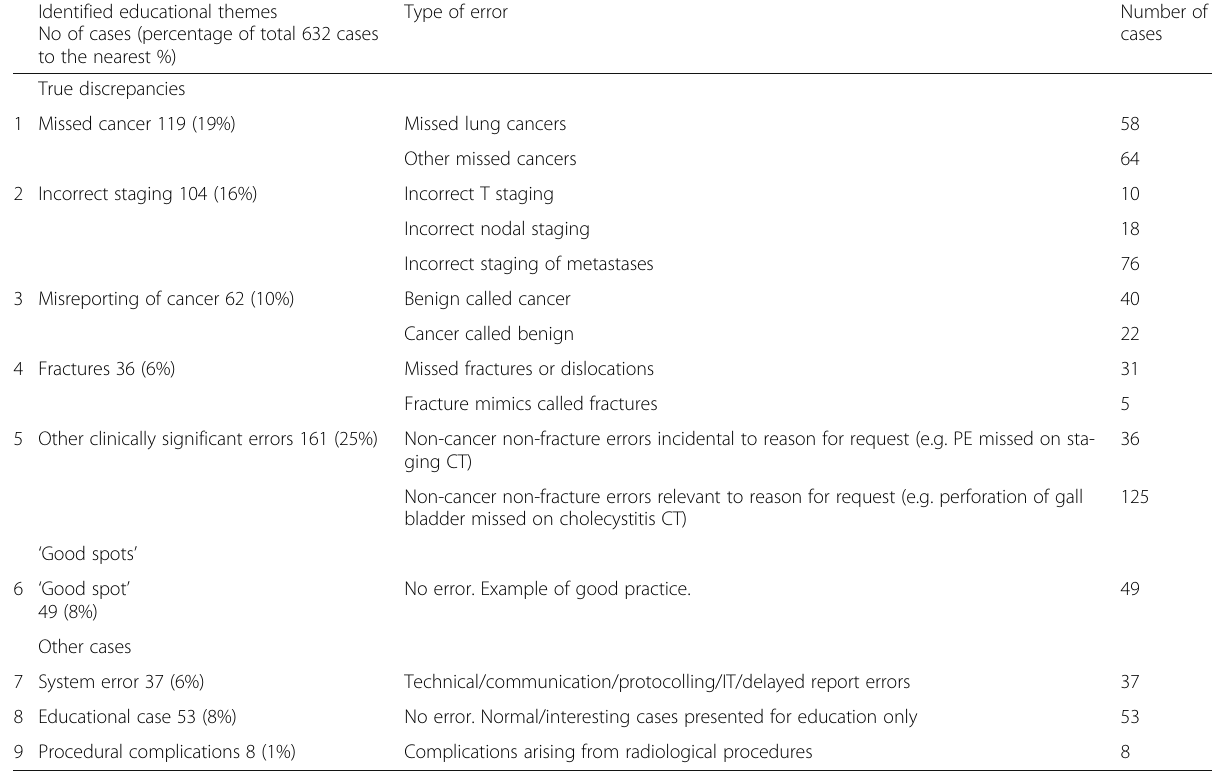
Table 2 Themes identified from submitted